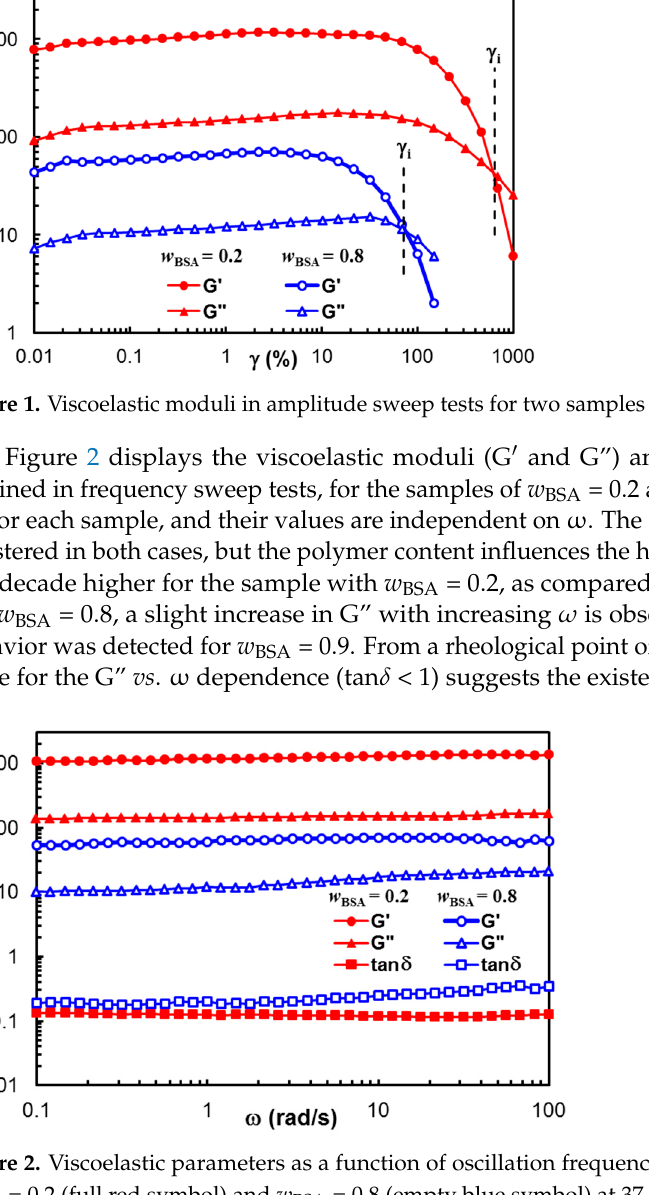
Figure 3. Viscoelastic parameters as a function of w BSA for PVA/HPC and hybrid polymer/BSA hydrogels after 3 freezing thawing cycles, ω = 1 rad/s, γ = 1%, at 25 °C (empty symbol, dashed line) and 37 °C (full symbol, continuous line). The lines are a guide to the eye. In addition, gelation of BSA was observed at 37 °C in the presence of GSH [61] in- volving a reduction in intramolecular disulfide bonds (cleaved by the thiol) and cross- linking through intermolecular disulfide bonds of the resulted free sulfhydryls from the protein. This process is dependent on the pH and concentration, and it is sensitive on species of anions in the environment. In the pH range from 5 to 7, disulfide bonds of BSA are not accessible to reducing agents, but they are gradually available as the pH increases between 7 and 8. At pH = 7.4, a partial transition from the normal conformation to a basic form of BSA occurs, and some disulfide bonds are involved in the gelation process. 3.2. Morphology of the Hydrogels The morphology of freeze-dried hydrogels was examined by SEM using fresh pre- pared samples frozen in liquid nitrogen and lyophilized for 3 days. Hydrogels with high polymer content (Figure 4a–d) present a porous structure with interconnected pores. The increase in BSA content into the polymer matrix reduces the average pore size from 22 μ m observed for the pure polymer hydrogel in the absence of BSA to 9.5 μ m for w BSA = 0.5. When BSA is predominant in the hydrogel, its macromolecules are associated in clusters and aggregates; the porous structure is perturbed, and a soft hydrogel with BSA rich zones is formed (Figure 4e,f). The cleavage and rearrangement of disulfide bonds occurring in BSA are triggered by GSH presence and gentle thermal treatment before applying the freezing/thawing cycles, resulting in a disulfide bridge network. A high